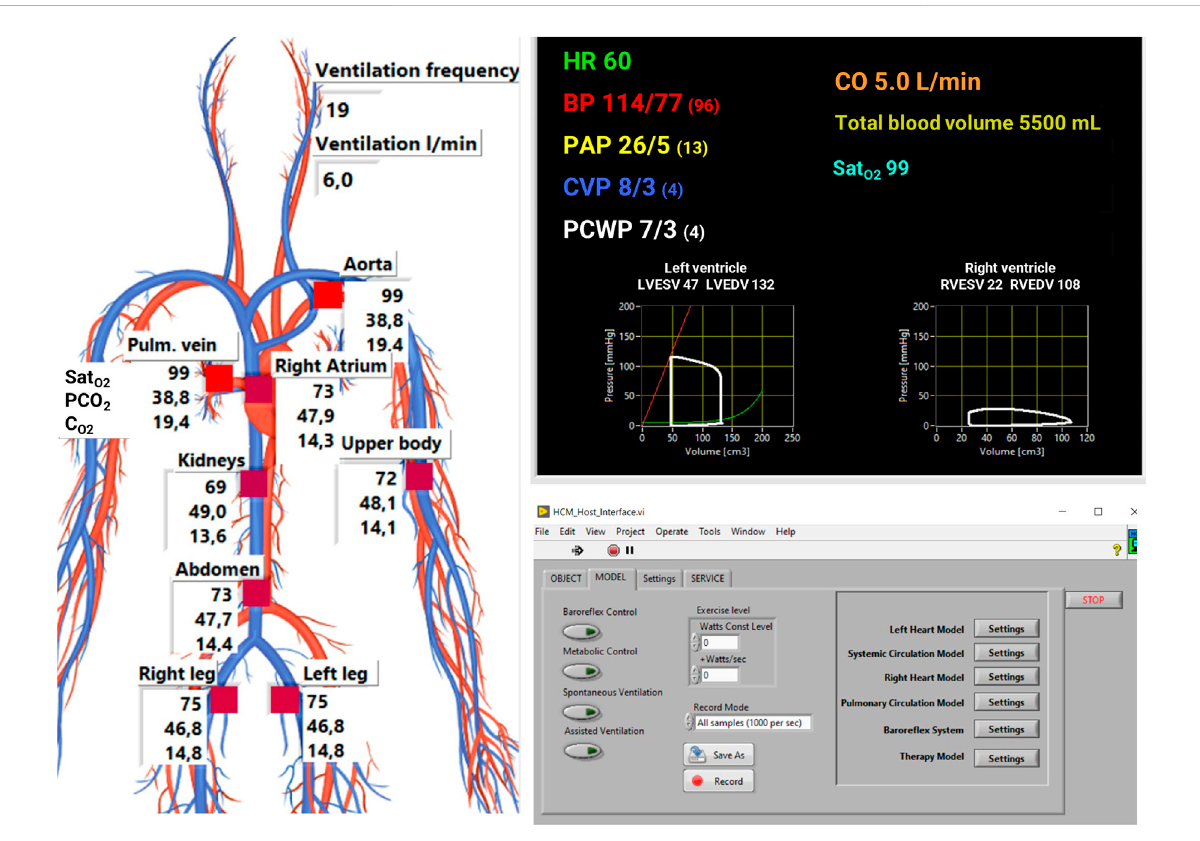
FIGURE 4 User interface of the simulator. Hemodynamic data are plot on the top right panel: heart rate ( HR ), systemic arterial pressure ( BP ), pulmonary arterial pressure ( PAP ), central venous pressure ( CVP ), pulmonary capillary wedge pressure ( PCWP ), cardiac output ( CO ), arterial oxygen saturation ( Sat O2 ). Respiratory parameters (saturation of O 2 , partial pressure of CO 2 and concentration of O 2 ) are plot on the left panel. A dedicated window (bottom right panel) is used to activate control mechanisms, change cardiorespiratory parameters, and to input the exercise level either manually as a constant value or as a slope of increase over